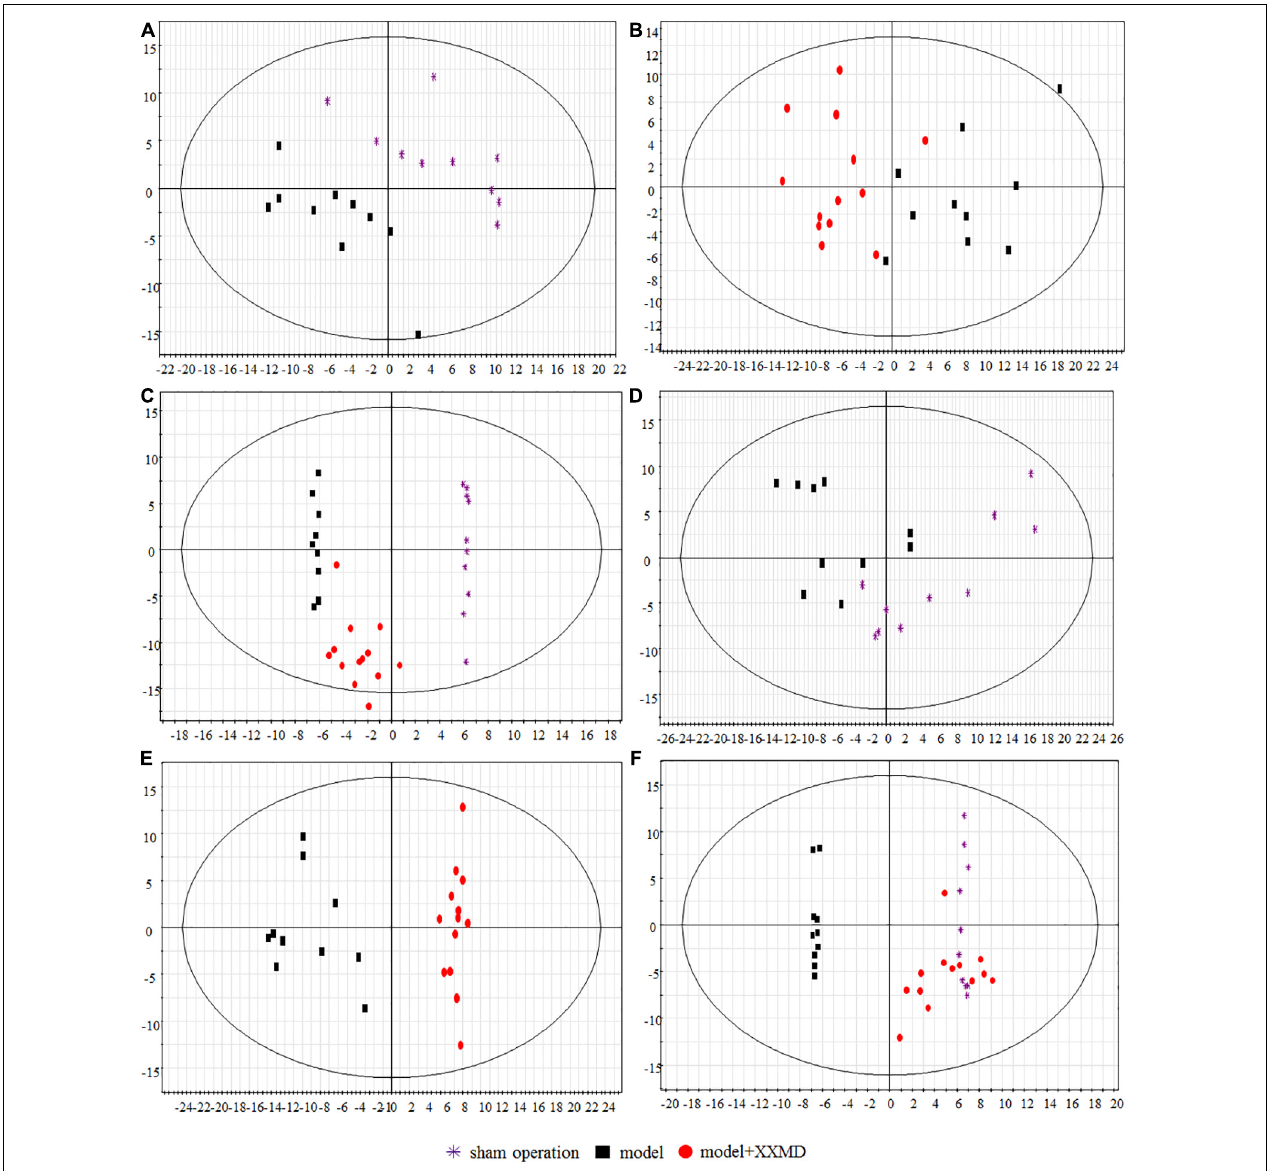
FIGURE 4 | Score scatter plots of lipids by PCA and T-prediction by OPLS-DA. (A) PCA, model group and sham operation group with respect to plasma. (B) PCA, dosed model group and model group with respect to plasma. (C) OPLS-DA, T predicted score scatter plots of the dosed model group with respect to plasma. (D) PCA, model group and sham operation group with respect to brain tissue. (E) PCA, dosed model group and model group with respect to brain tissue. (F) OPLS-DA, T predicted score scatter plots of the dosed model group with respect to brain